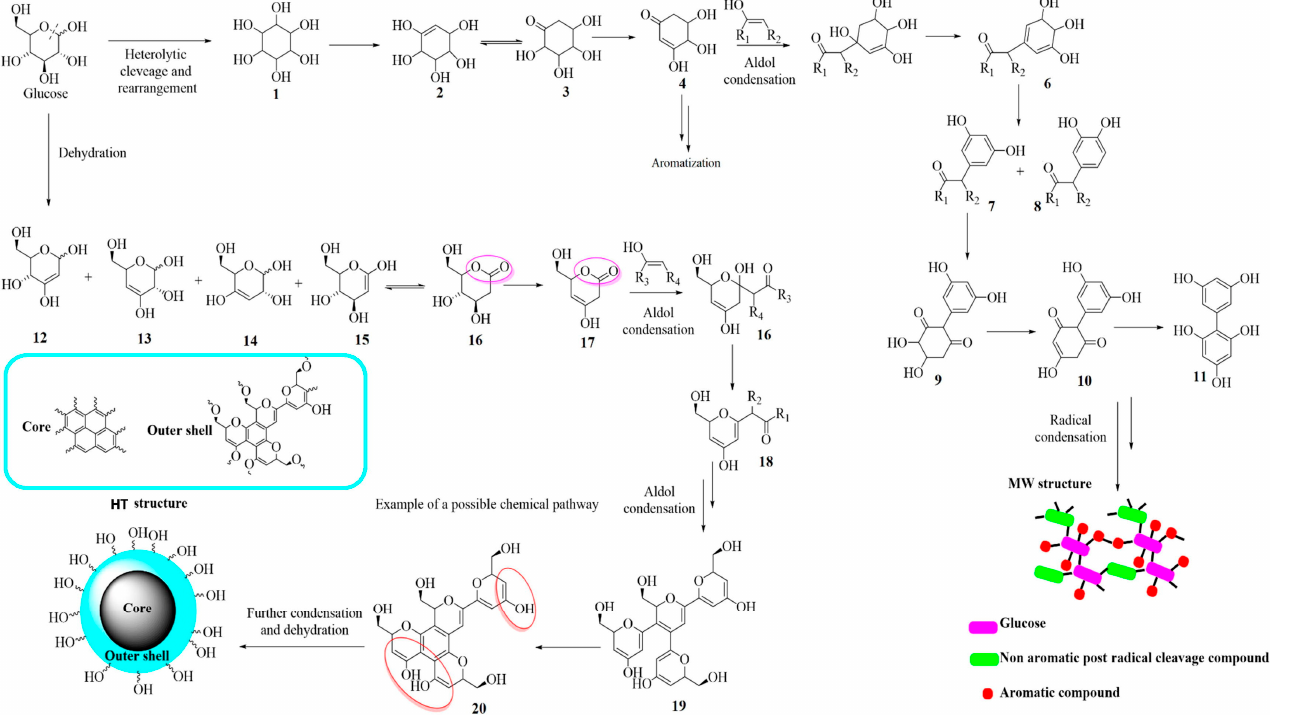
Figure 8. Schematic chemical pathway for the production of GQDs or PCDs using glucose as precursors and different synthetic routes. Reprinted with permission from Seven et al. [136].